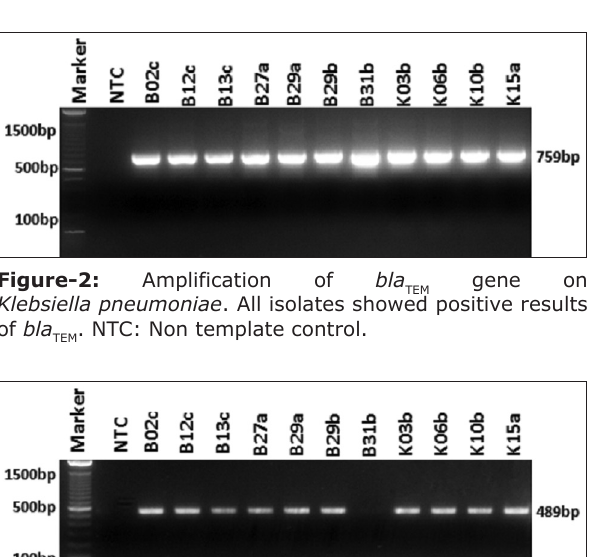
Figure-3: Amplification of bla gene on CTX-M Klebsiella pneumoniae . A total of 10 isolates showed positive results of bla . NTC: Non template CTX-M